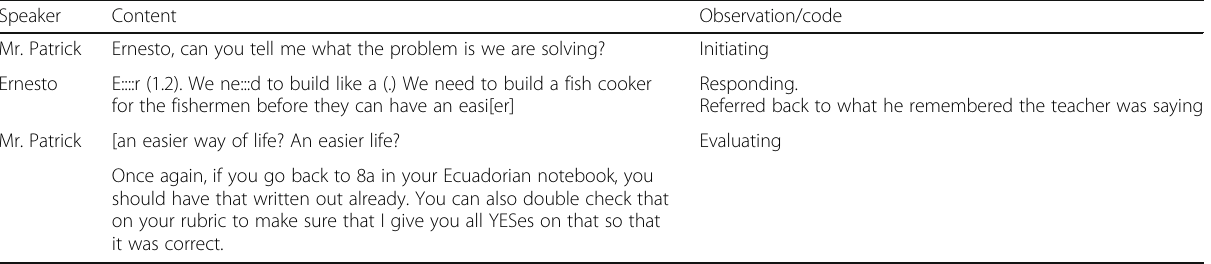
Table 2 Conversation between Mr. Patrick and Ernesto during the last day of the unit in lesson 12